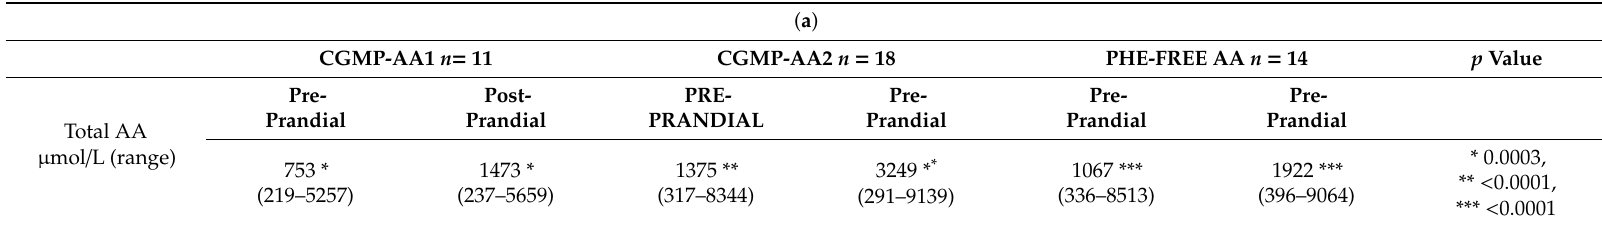
Table 3. ( a ) Median pre and postprandial total amino acids results for CGMP-AA1, CGMP-AA2, and PHE-FREE AA protein substitutes. ( b ) Median pre and postprandial EAA for CGMP-AA1, CGMP-AA2, and PHE-FREE AA protein substitutes. ( c ) Median pre and postprandial BCAA for CGMP-AA1, CGMP-AA2, and PHE-FREE AA protein substitutes. ( d ) Median pre and postprandial LNAA for CGMP-AA1, CGMP-AA2, and PHE-FREE AA protein